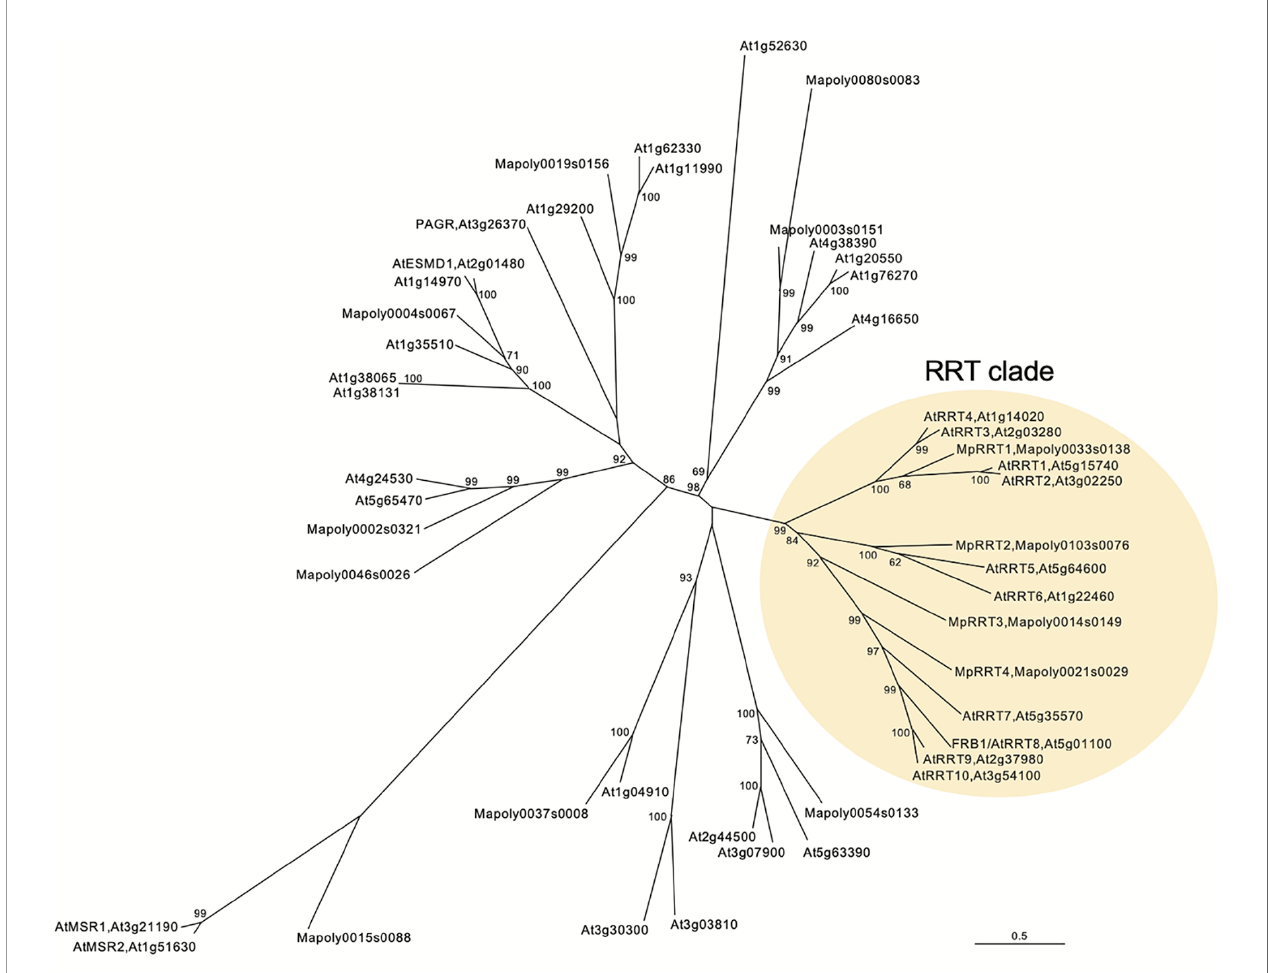
FIGURE 6 | A neighbor joining phylogenetic tree of Marchantia polymorpha and Arabidopsis thaliana GT106 proteins. Amino acid sequences of 34 Arabidopsis and 13 Marchantia GT106 proteins were aligned using ClustalW, and bootstrap analyses were performed with 1,000 replicates. The RG-I rhamnosyltransferase (RRT) clade is highlighted in pale yellow. Scale bar indicates the number of amino acid substitutions per